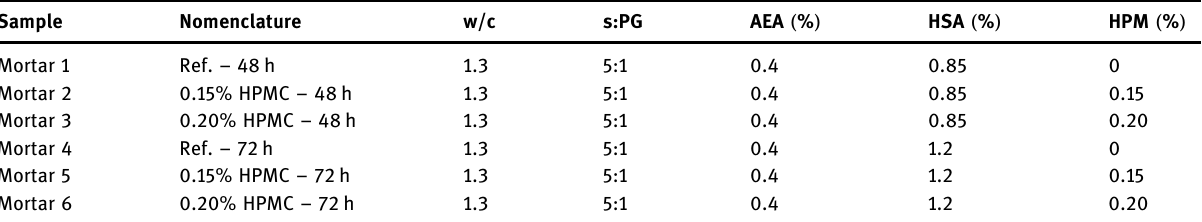
Table 4: Proportions of mixtures for the stabilized mortars